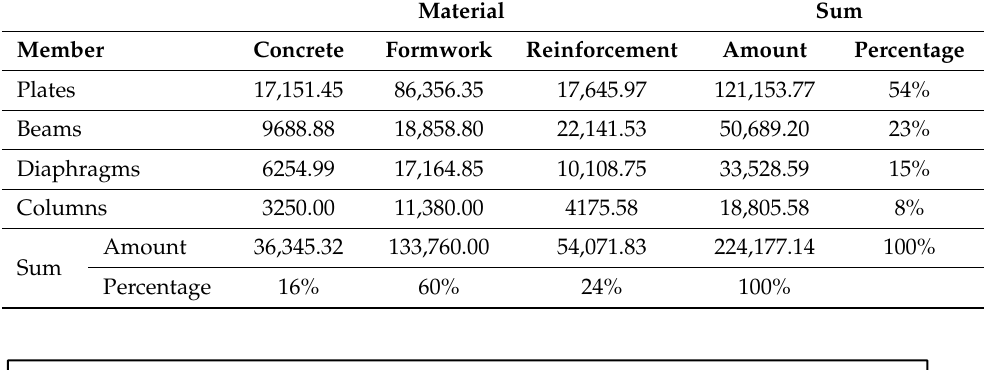
Table 21. Distribution of the optimum cost values among different materials and structural parts for the V-type folded plate roof building.